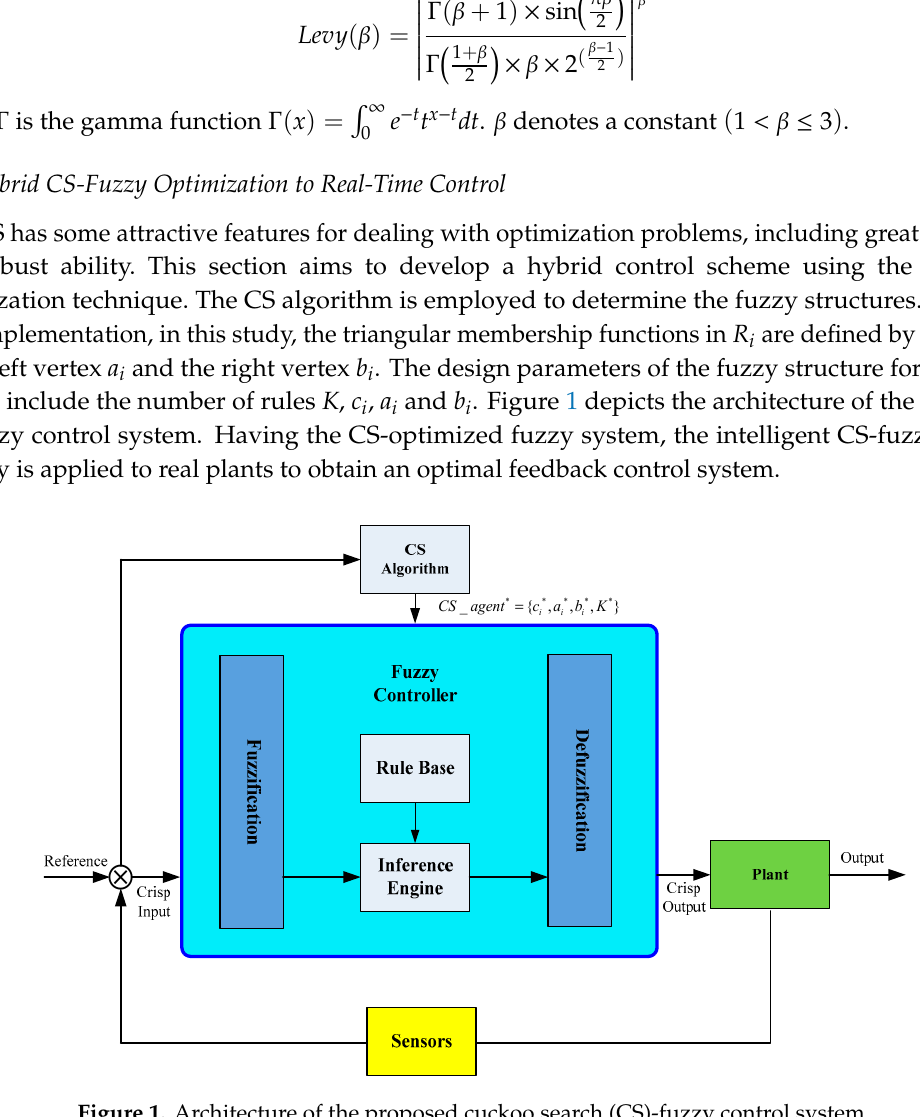
Figure 1. Architecture of the proposed cuckoo search (CS)-fuzzy control system.